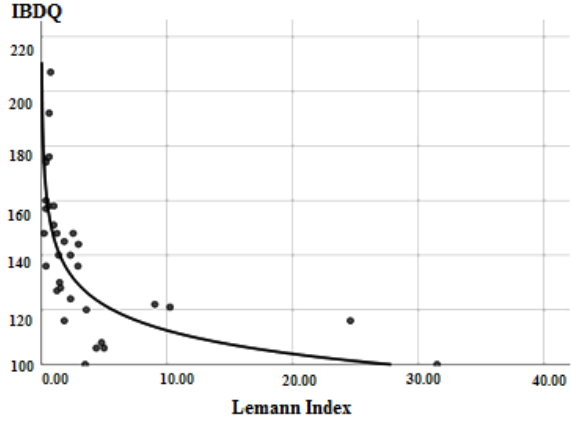
Figure 2: ROC curve analysis of MR-EC in predicting endoscopic Crohn’s disease activity.